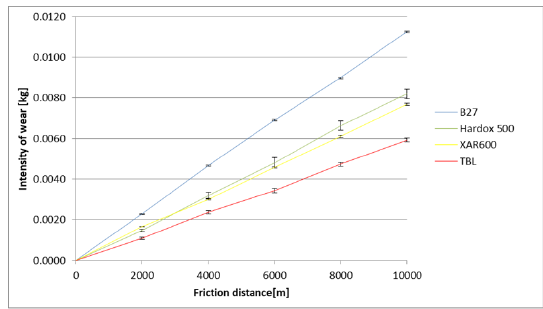
Figure 8. The course of the wear in the heavy soil.